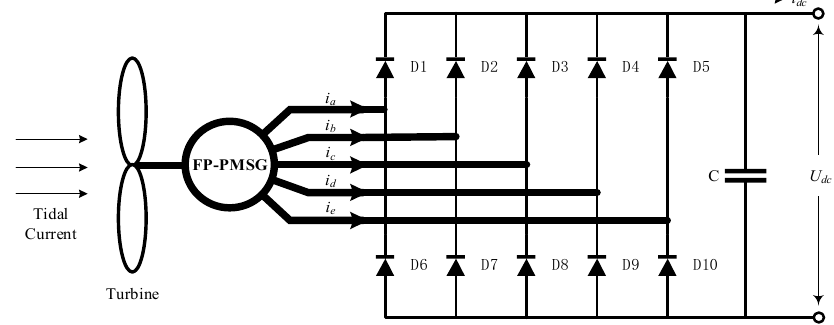
Figure 1. Structure of the studied marine current generator set (MCGS).